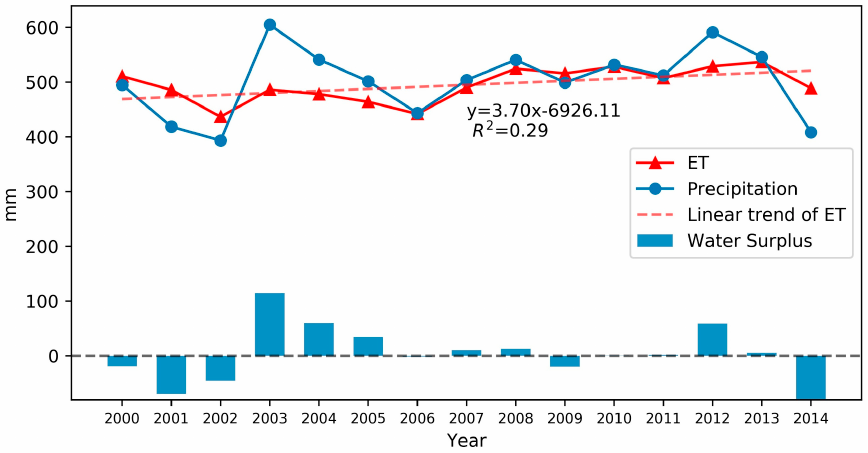
Figure 5. The trends of ET, precipitation and water surplus from 2000 to 2014 in the Hai Basin. Table 1. Tests of ET, water surplus and precipitation trends from 2000 to 2014.